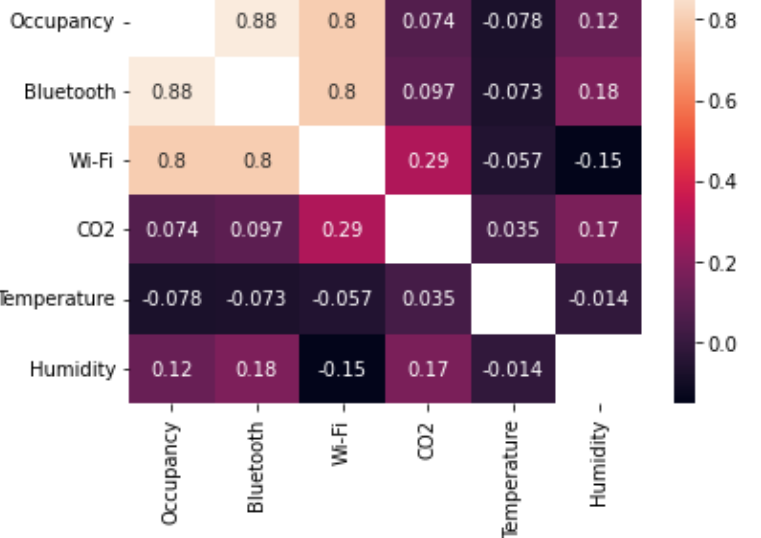
Figure 4. Correlations of features.